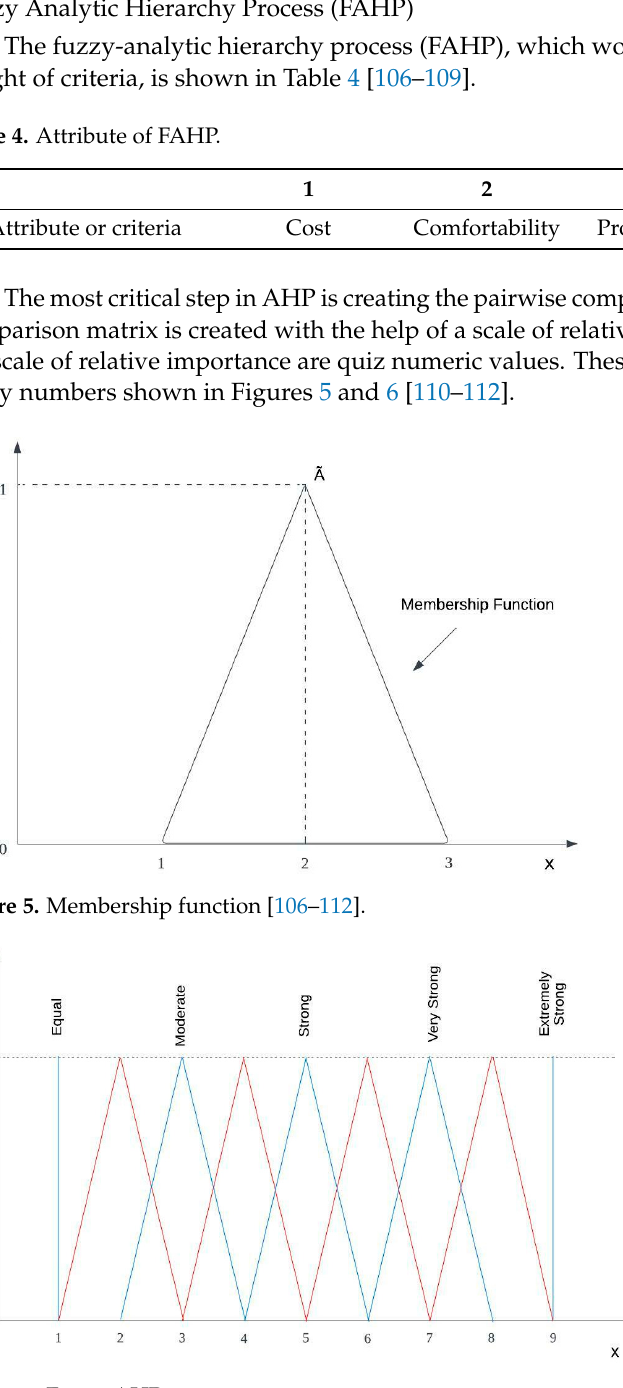
Table 4. Attribute of FAHP.